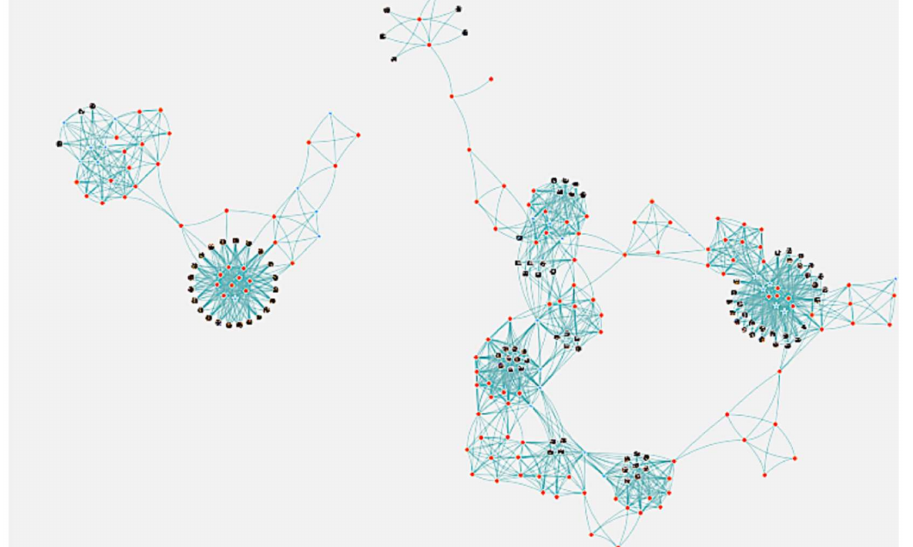
Figure 11. Presentation results of memory fragments from one year of user experience (1 April 2016 to 30 March 2017) generated as an